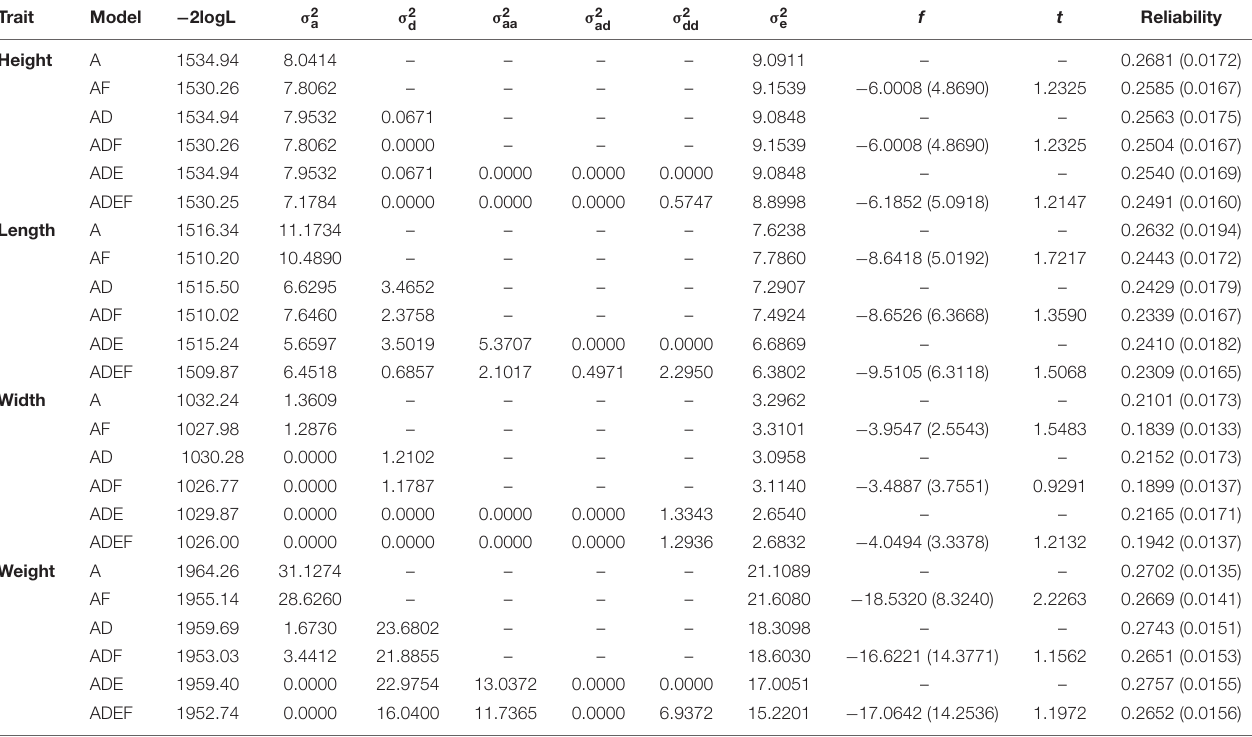
TABLE 1 | Variance components and genomic prediction reliabilities of different models for growth traits of the bay scallop. Trait